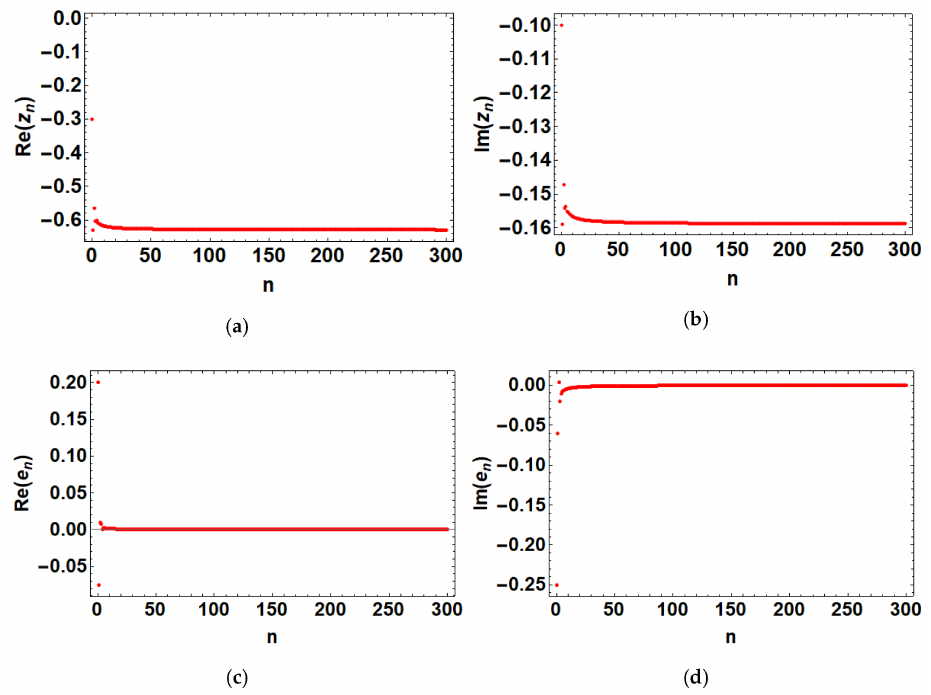
Figure 10. ( a , b ) Stabilization of fixed point ¯ z = − 0.62932 − 0.1589 i of the generalized fractional cosine map under the influence of the proposed controller (11) with κ = 1. ( c , d ) The real and imaginary parts of the synchronization error between a master system with p = 2, q 1 = 1.2 − 0.2 i , α = 0.9 and a slave system with p = 2, q 2 = 0.433 − 0.55 i and α = 0.9 when the adaptive controller (15) is employed and γ = 1 + 0.3 i .